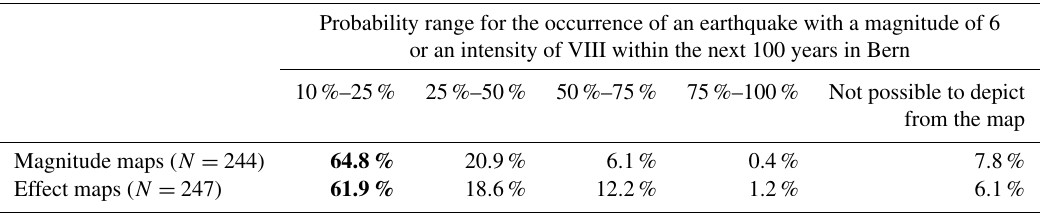
Table 10. Percentages of probability ranges selected with maps displayed. The correct answers are highlighted in bold font. Probability range for the occurrence of an earthquake with a magnitude of 6 or an intensity of VIII within the next 100 years in Bern